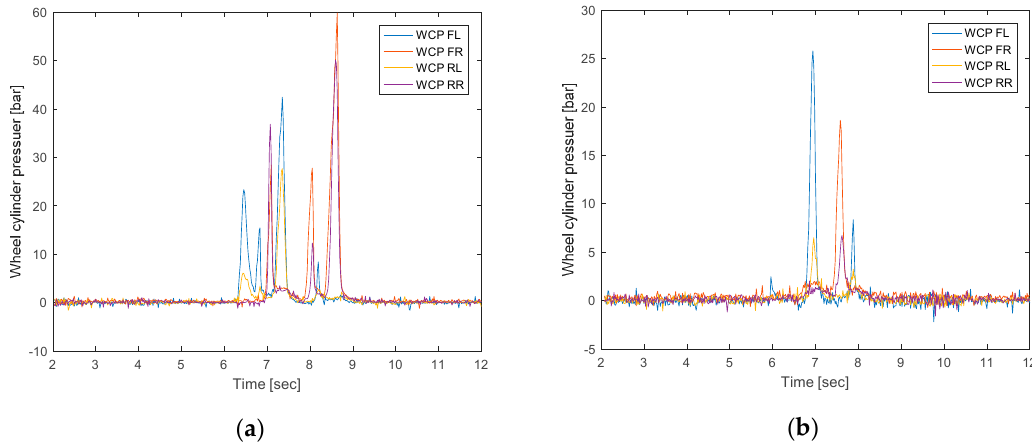
Figure 26. Based on the traditional PID control, the brake wheel cylinder pressure value under the test condition of the maximum steering angle is shown. ( a , b ) are the brake wheel cylinder pressure values of the vehicle model using traditional PID control when the maximum steering angle is 270 deg and the road adhesion coefficient is 0.5 and 0.8.